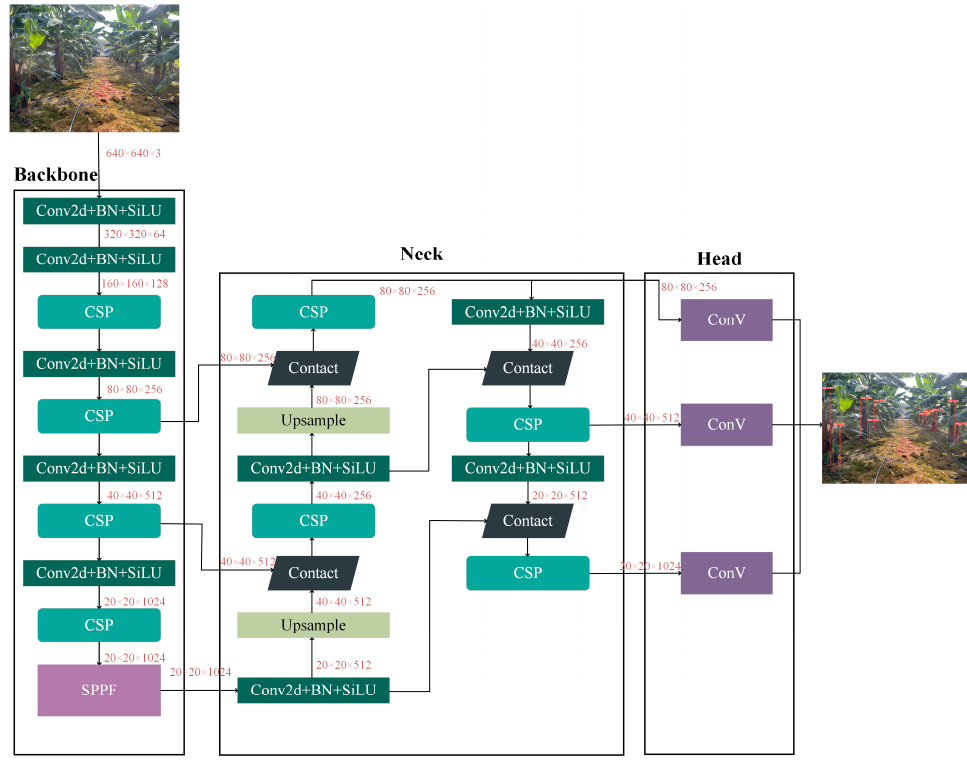
Figure 4. YOLOv5 architecture.